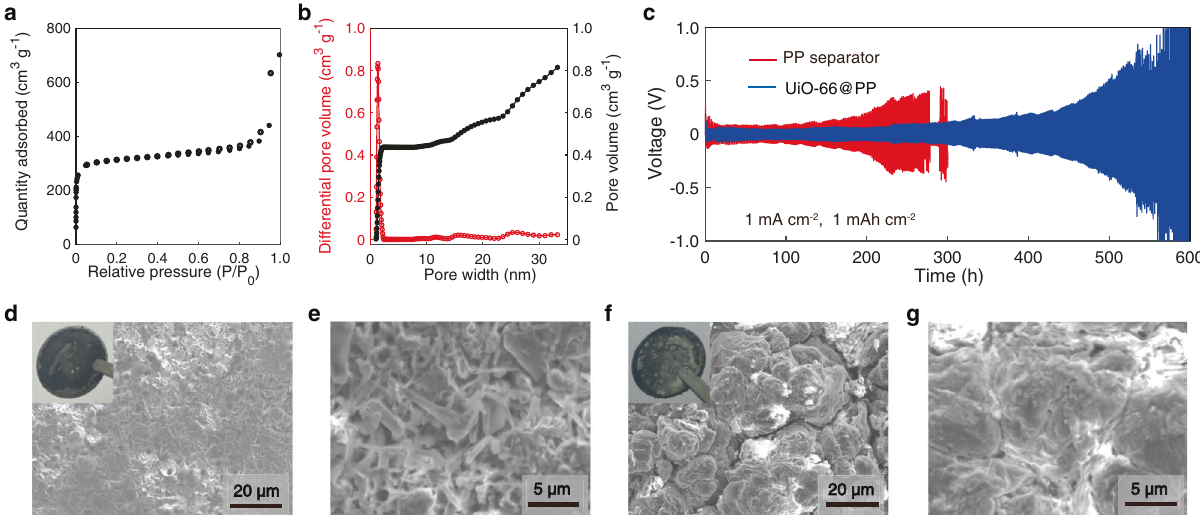
Fig. 6 Electrochemical performance of UiO-66@PP separator. a , b Nitrogen-sorption isotherm curves and pore size distribution (red) and cumulative pore volume (black) pro fi les measured at 77 K of UiO-66 after ball-milled, respectively. c Voltage vs. time for symmetric lithium cell where each half-cycle lasts 1 h. Initial voltage pro fi les of the PP separator (red curve), UiO-66@PP (blue curve)-based cells at a fi xed current density of 1 mA cm − 2 (1 mAh cm − 2 ). SEM images of the lithium metal anode after 120 h cycling: d , e The PP separator-based symmetric lithium cell. f , g UiO-66@PP-based symmetric lithium cell. The insets show the lithium metal after 120 h cycling in different cells: the PP separator and UiO-66@PP-based symmetric lithium cells,